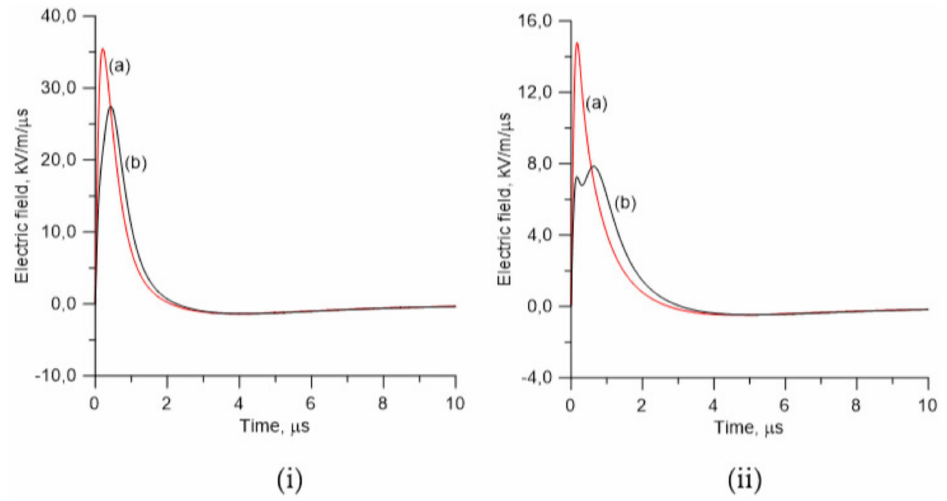
Figure 4. The derivative of the vertical electric field at the point of observation for a subsequent return stroke. ( i ) d = 50 m, ζ = 20 m; ( ii ) d = 100 m, ζ = 10 m. The speed of propagation of the pulse is 1.5 × 10 8 m/s. The curve marked (a) in red represents the exact and (b) in black represents the Rusck approximation.